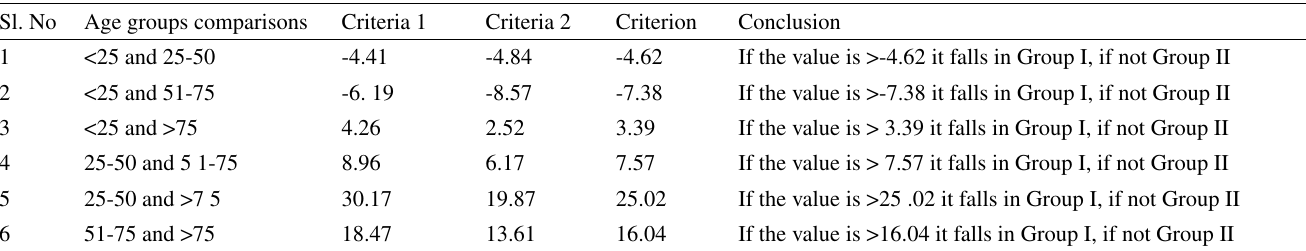
Table 8 - Criteria and criterion for discrimination of age groups in mangosteen ( Garcinia mangostana L.) Sl.